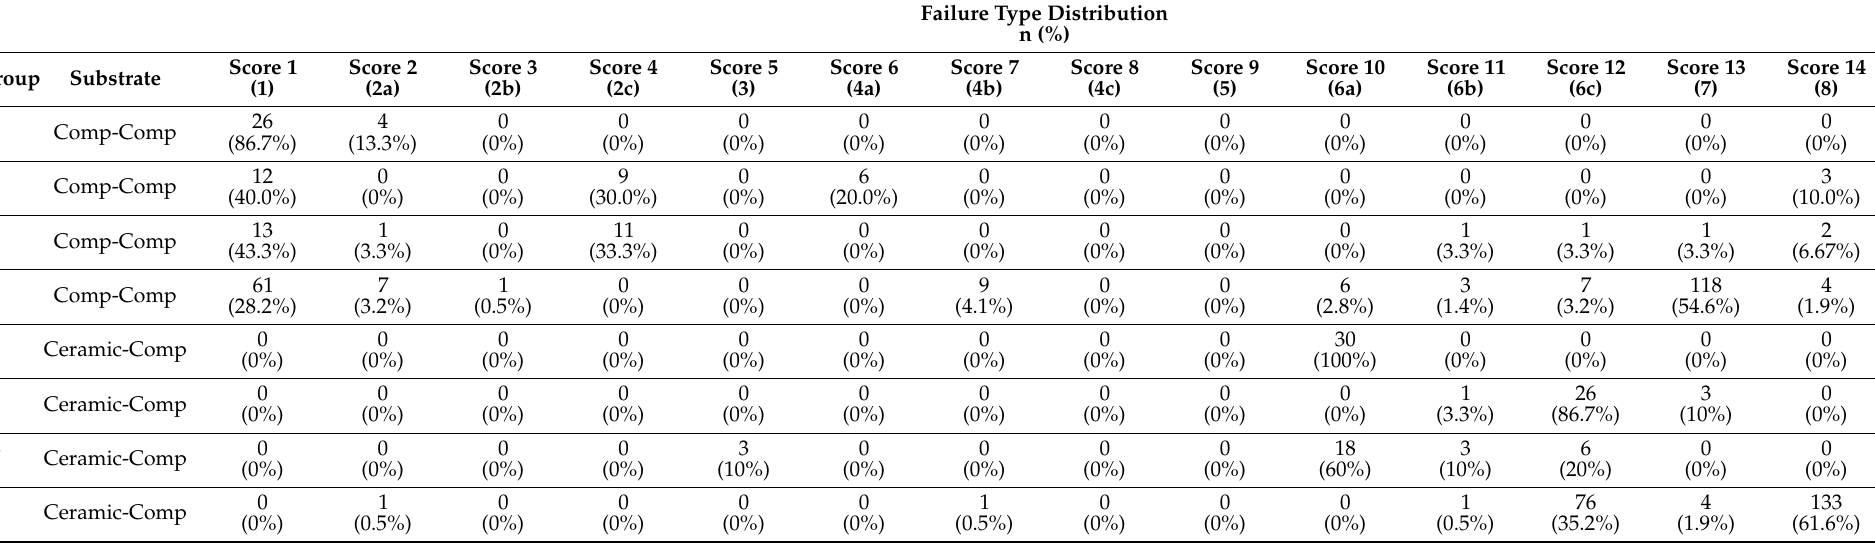
Table 3. Frequency and distribution of failure type per experimental group analysed after bond strength test: Score 1: cohesive failure in the substrate; Score 2a: mixed cohesive failure in substrate and cohesive or adhesive failure in bond (>50% in bond); Score 2b: mixed cohesive failure in substrate and cohesive or adhesive failure in bond (> or <50% in bond and 50% in substrate); Score 2c: mixed cohesive failure in substrate and cohesive or adhesive failure in bond (>50% in substrate); Score 3: adhesive failure between substrate and bond, Score 4a: mixed cohesive and adhesive failure in bond (>50%) adhesive failure between bond and substrate; Score 4b: mixed cohesive and adhesive failure in bond (>50%) cohesive failure in bond; Score 4c: mixed cohesive and adhesive failure in bond (>50%) adhesive failure between bond and adherent; Score 5: adhesive failure between bond and adherent; Score 6a: mixed cohesive failure in adherent and cohesive or adhesive failure in bond (>50% in bond); Score 6b: mixed cohesive failure in adherent and cohesive or adhesive failure in bond (> or <50% in bond and 50% in adherent; Score 6c: mixed cohesive failure in adherent and cohesive or adhesive failure in bond >50% in adherent); Score 7: cohesive failure in adherent, Score 8: cohesive failure in substrate, bond, and